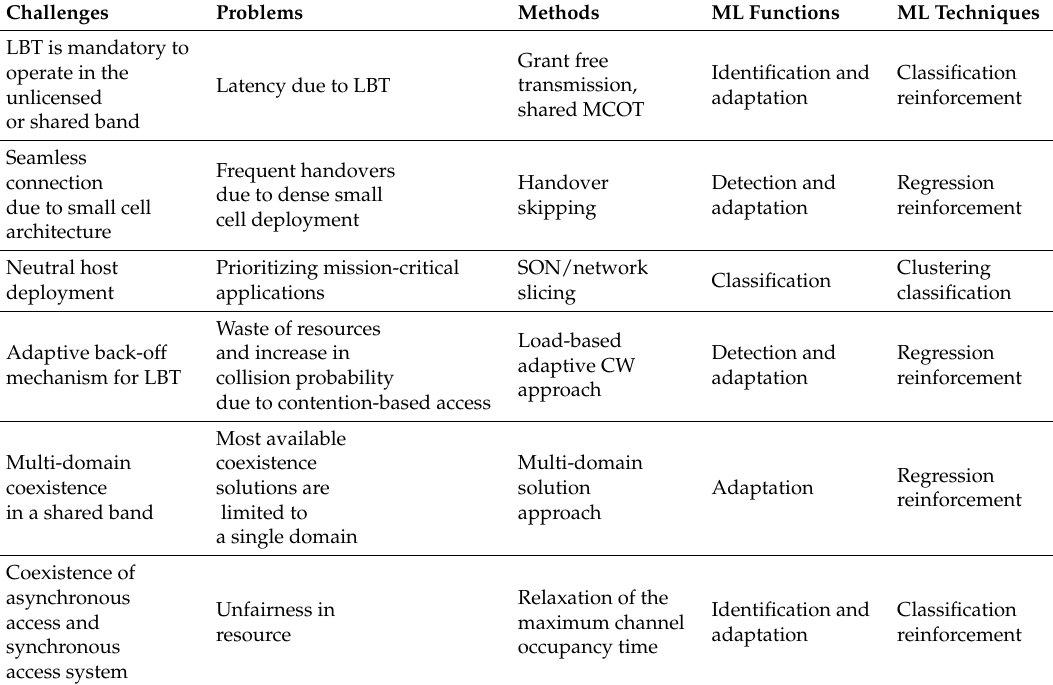
Table 7. Summary of the challenges and the ML techniques. SON, self-organized network; CW, contention